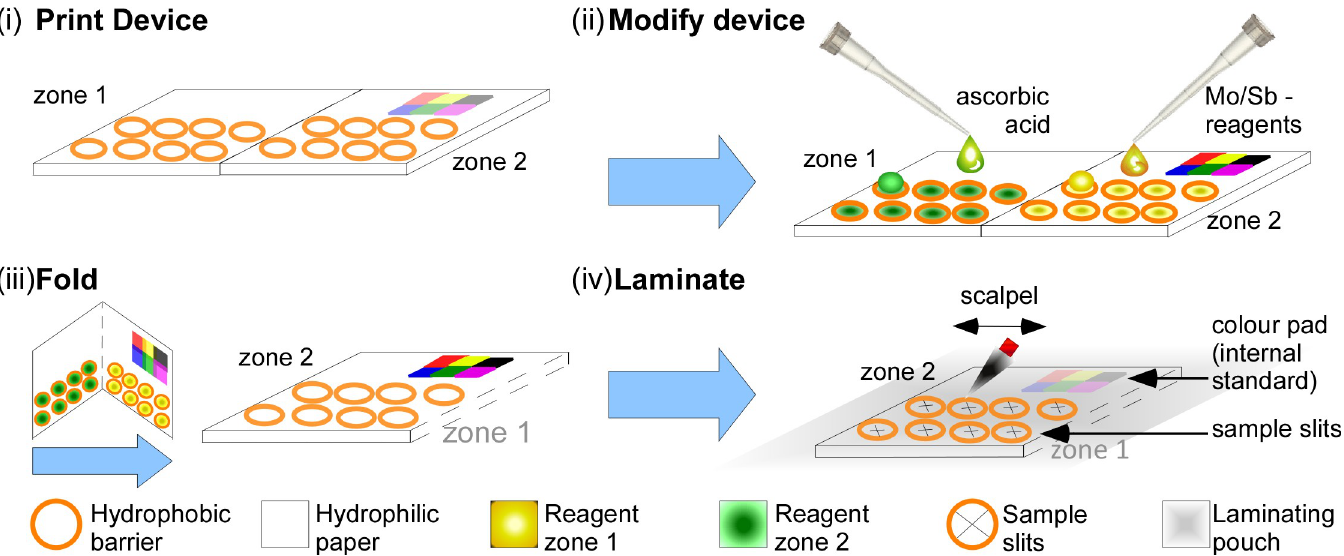
Fig 1. Production of PAD. (i) Circular reaction zones were wax printed onto filter paper. (ii) Ascorbic acid solution was added to each circle in zone 1, Mo/Sb reagent to each circle in zone 2. After drying, the paper was backfolded to align the sample zones. (iii) Devices were sealed by lamination to encase the reagents and prevent contamination. (iv) Slits were cut into the back of the device (zone 1) to allow for sample entry.